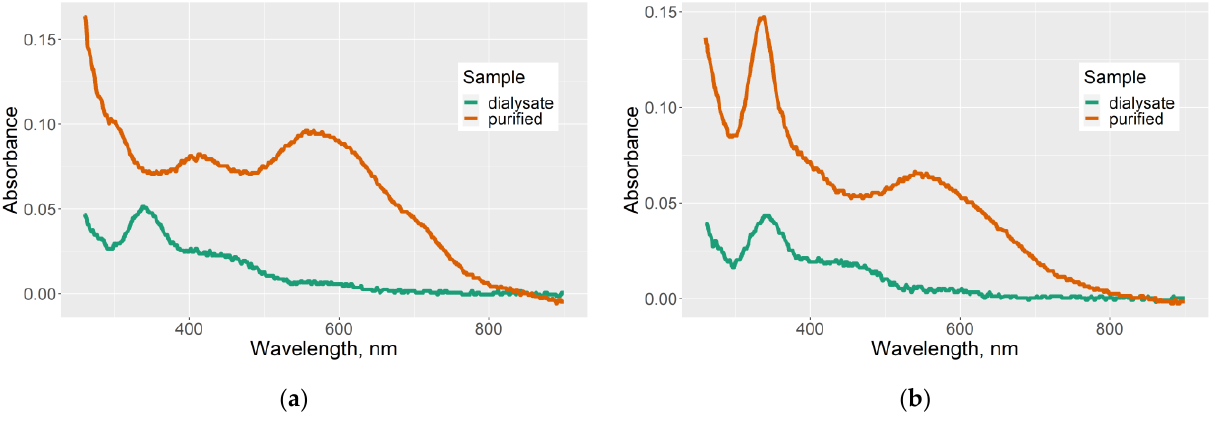
Figure 5. Comparison of electronic absorption spectra of the dialysates and purified samples. Initial mixture composition: ( a ) urea/citric acid = 1:1; ( b ) thiourea/citric acid = 1:1.